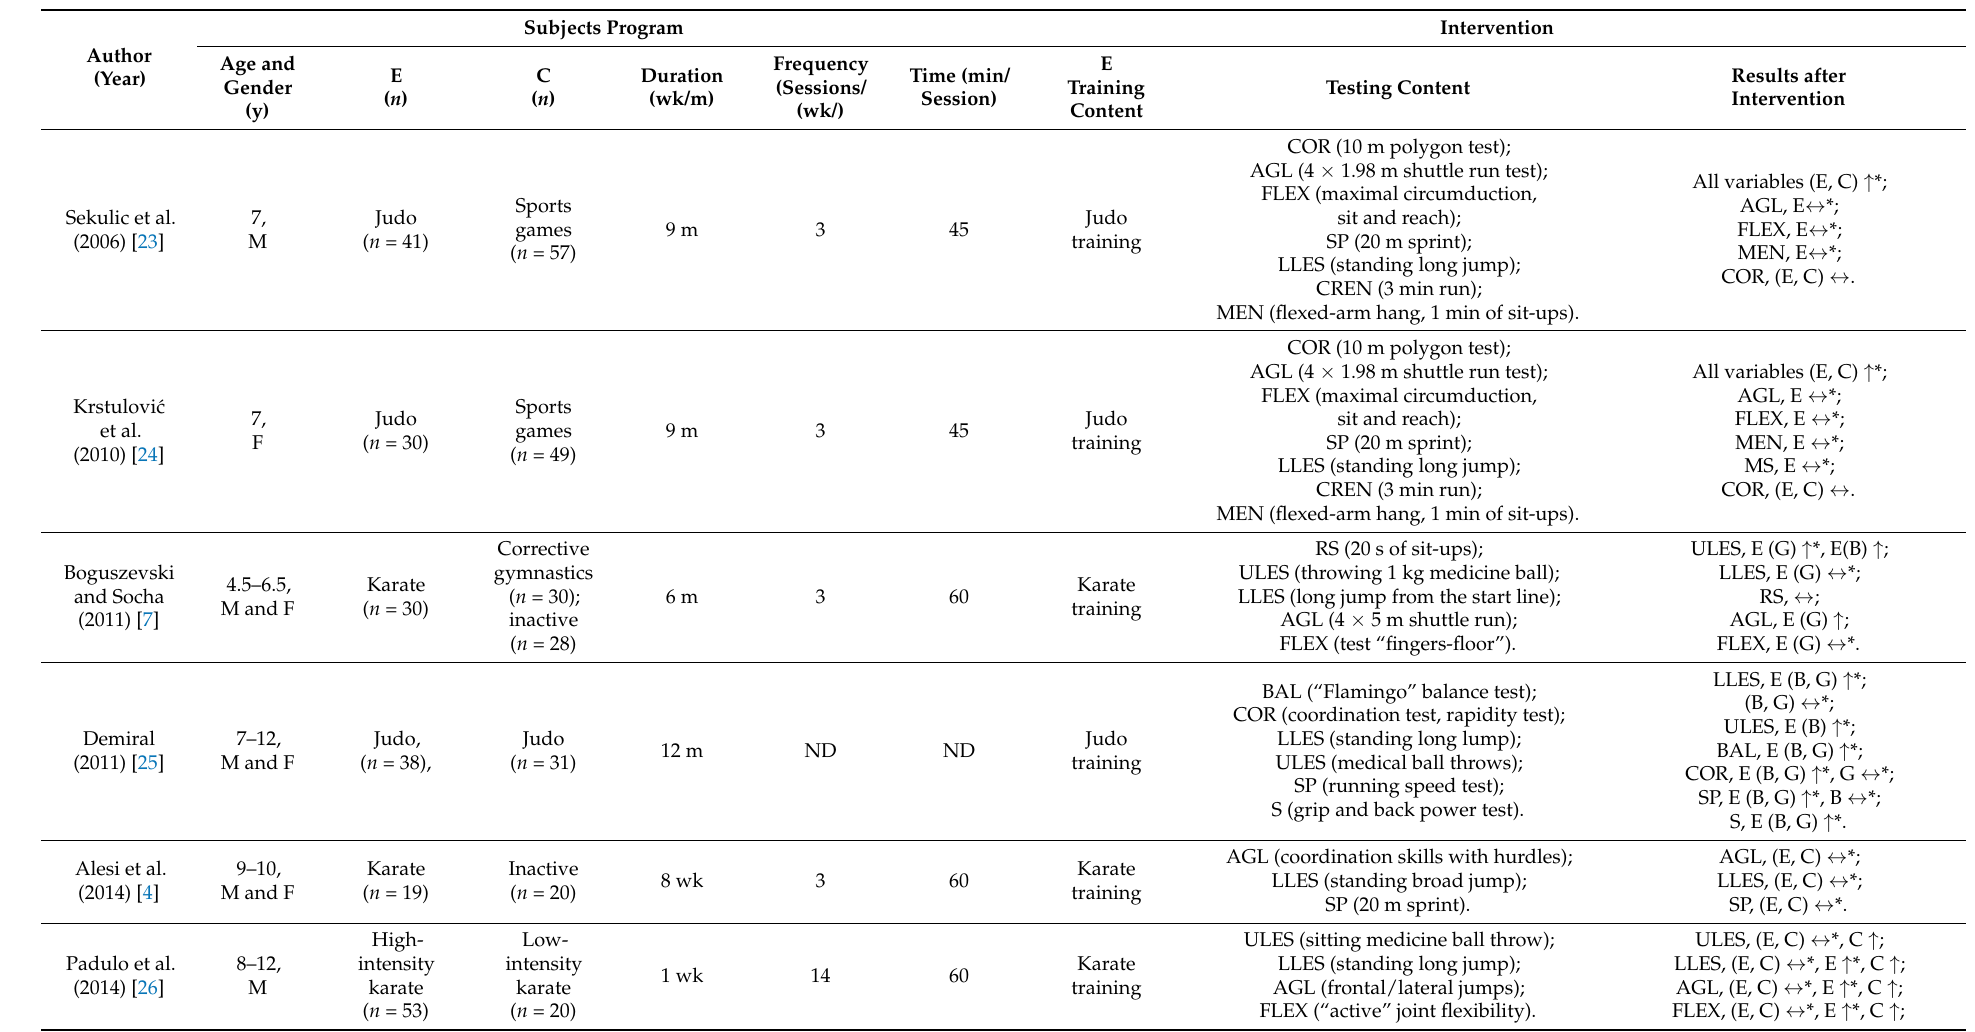
Table 1. Results of the included